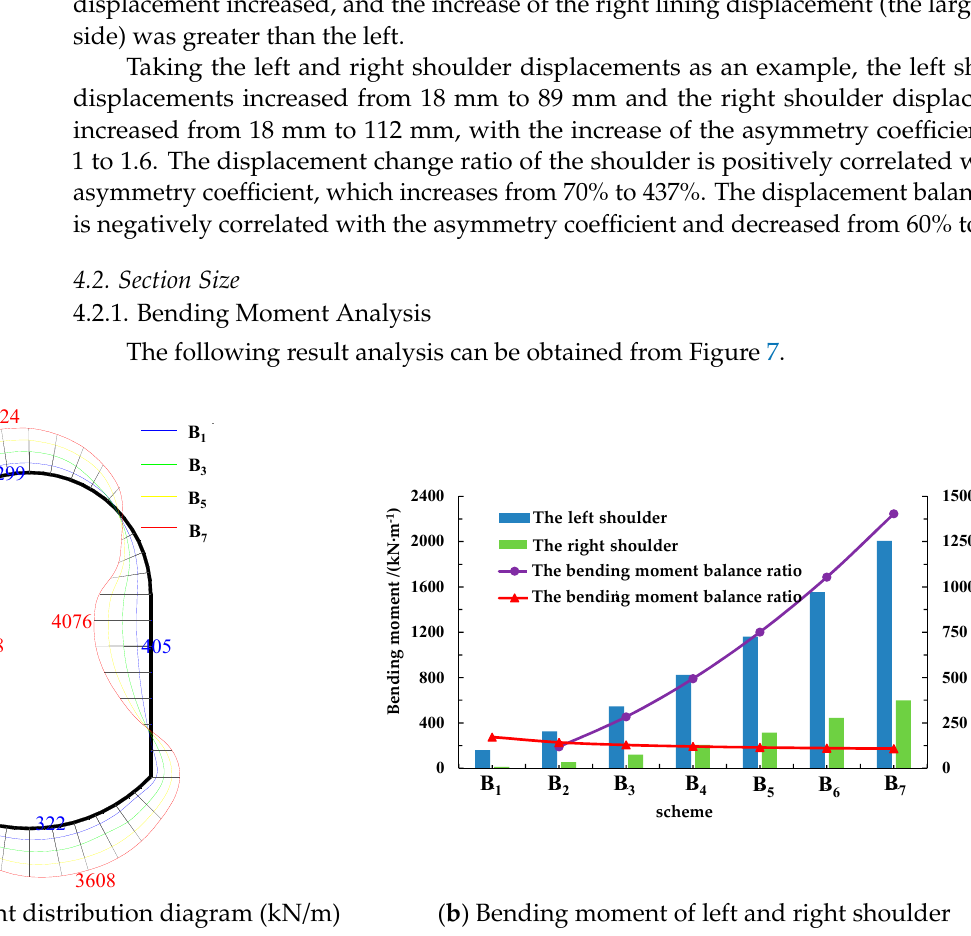
Figure 7. Bending moment analysis of different section sizes. ( a ) Bending moment distribution diagram ( b ) Bending moment of left and right shoulder.